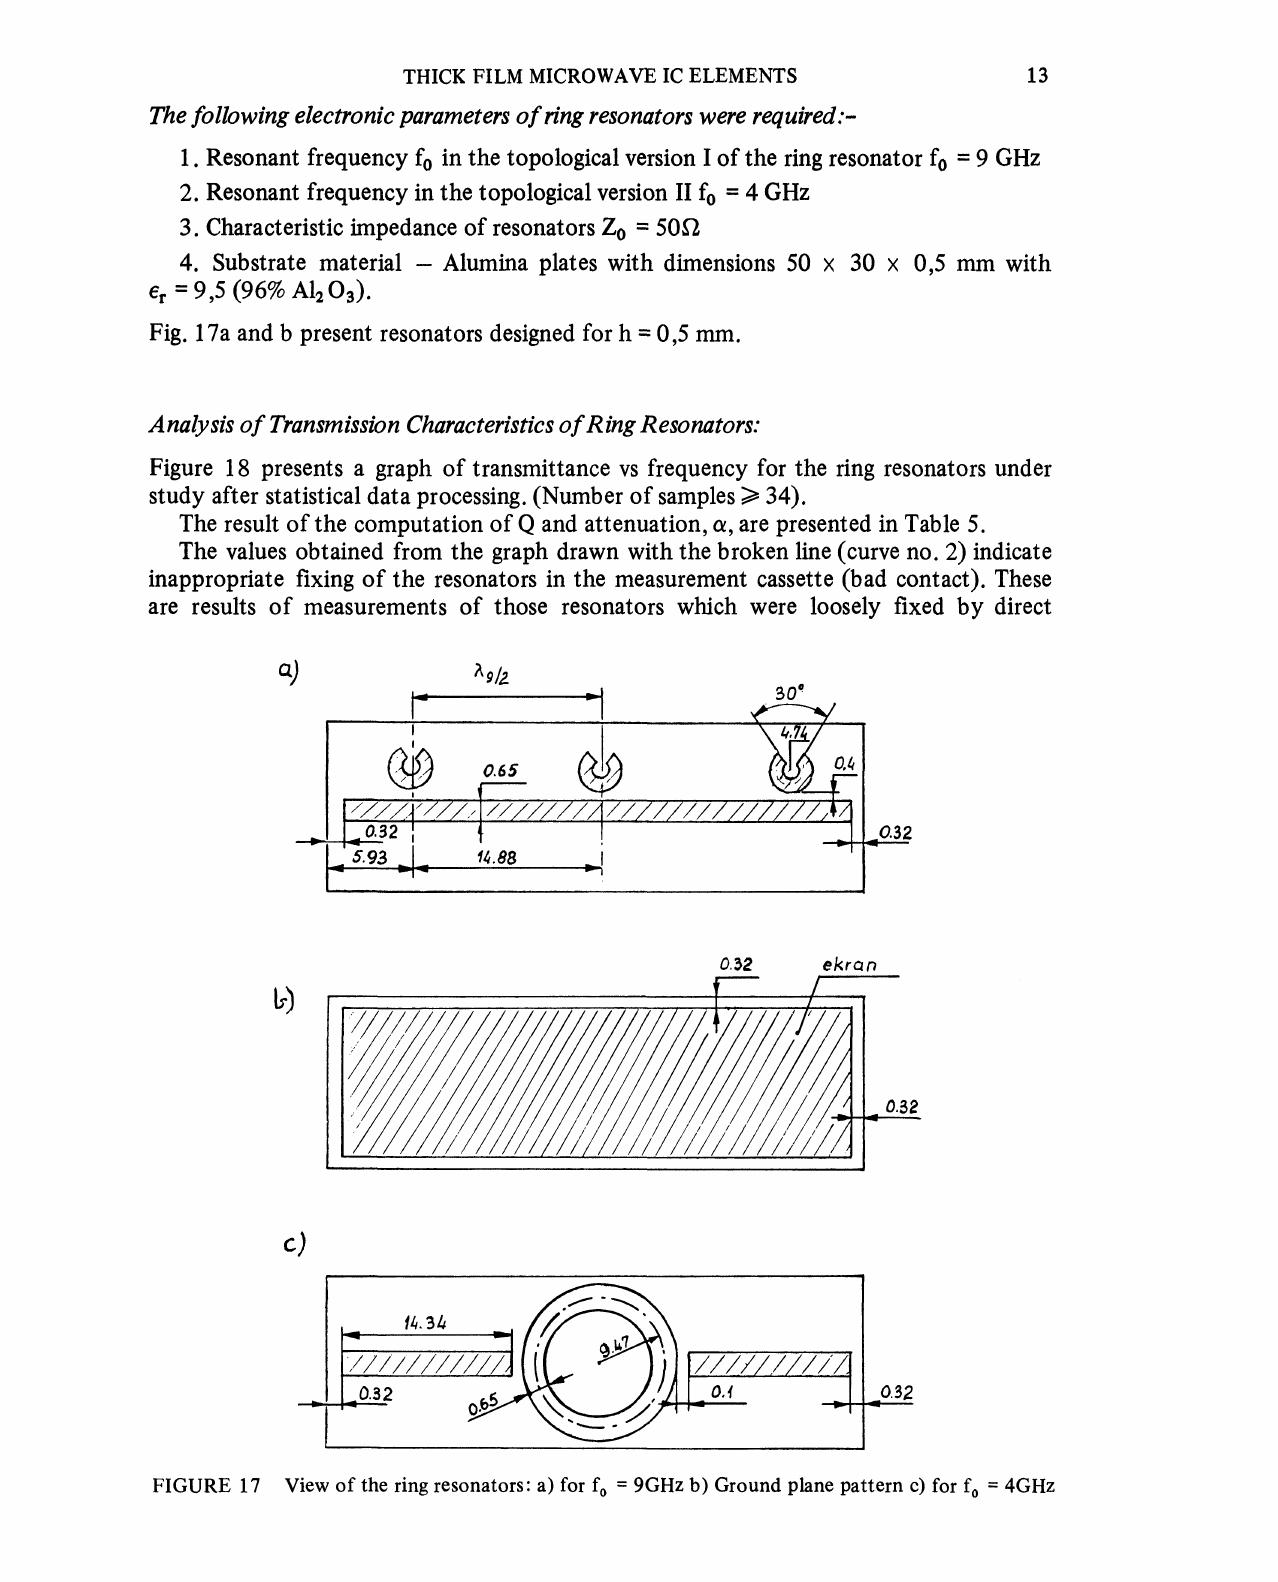
FIGURE 17 View of the ring resonators: a) for fo 9OHz b) Ground plane pattern c) for fo